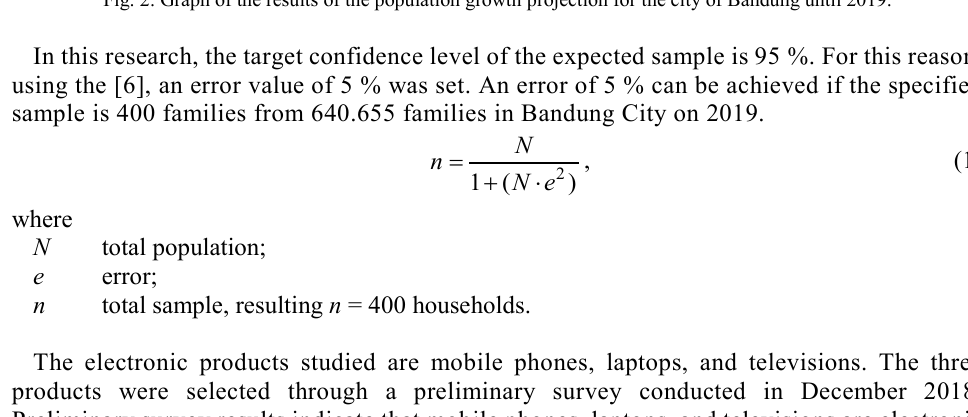
Fig. 2. Graph of the results of the population growth projection for the city of Bandung until 2019.